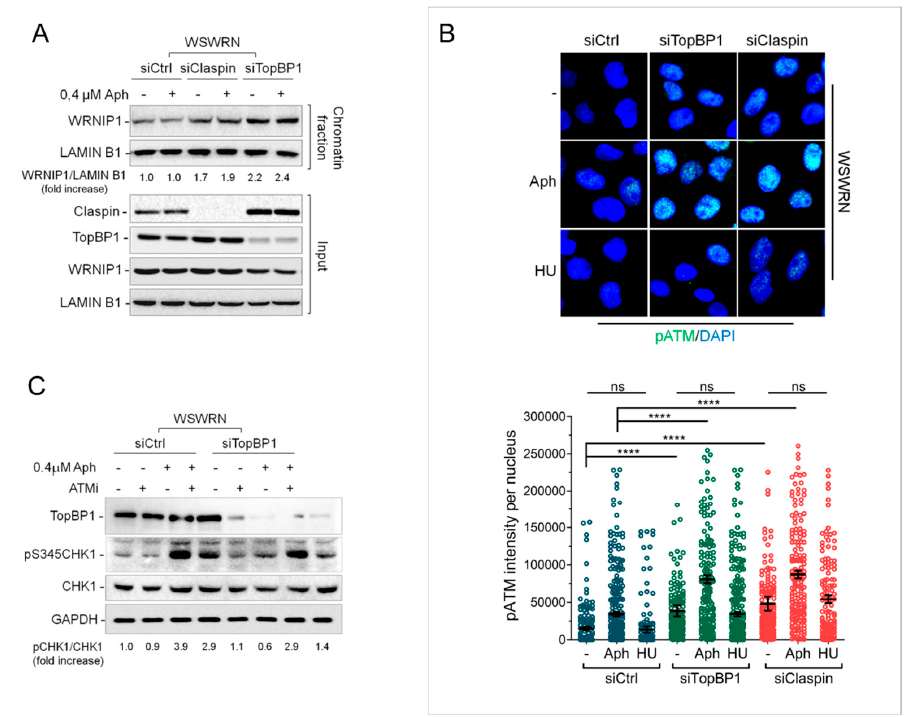
Figure 3. Impairment of the ATR-CHK1 signaling triggers a WRNIP1-mediated ATM activation. ( A ) WB analysis of chromatin binding of WRNIP1, performed as in Figure 2A. WSWRN cells were transfected with GFP, Claspin, or TopBP1 siRNA for 48 h and treated with Aph. The membrane was probed with the indicated antibodies. The normalized ratio of the chromatin-bound WRNIP1 / LAMIN B1 is reported; ( B ) IF analysis of cells depleted of Claspin or TopBP1 as in (A) and stained for pATM (S1981). Bar graph shows pATM intensity per nucleus. Error bars represent standard error. WB using the indicated antibodies confirms depletion of Claspin and TopBP1; ( C ) WB analysis of the presence of activated, i.e., phosphorylated, CHK1 assessed using S345 phospho-specific antibody (pS345) in WSWRN cells depleted for TopBP1 as in ( A ) and treated with Aph. ATMi was added 1 h prior to Aph and used as a negative control. The membrane was probed with the indicated antibodies. The normalized ratio of the phosphorylated CHK1 / total CHK1 is given.